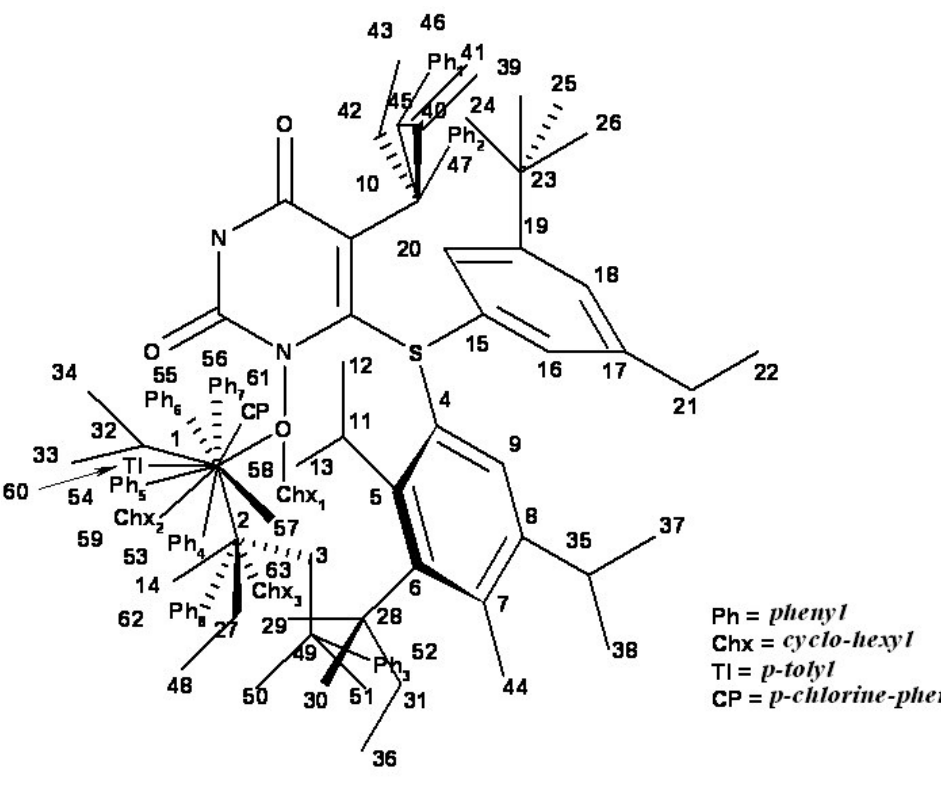
Figure 5. Hypermolecule H obtained by superposition of the minimum energy conformations of the 79 HEPT derivatives (M = 63